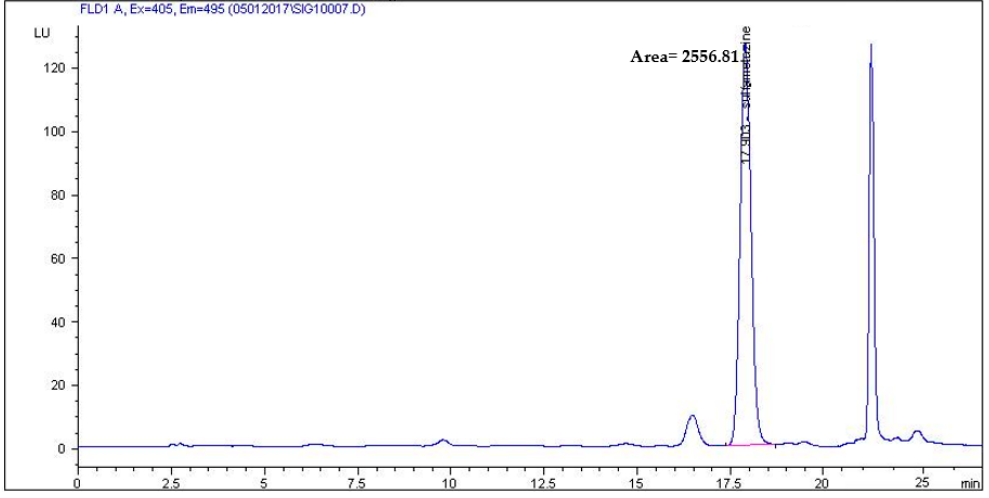
Figure 7. Chromatogram of feed sample that contained 1548 µg/kg of sulfamethazine.